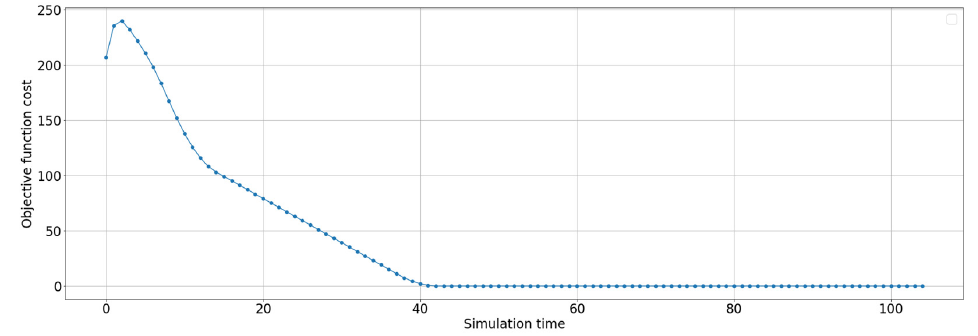
Figure 10. Objective function cost of the centralised MPC.